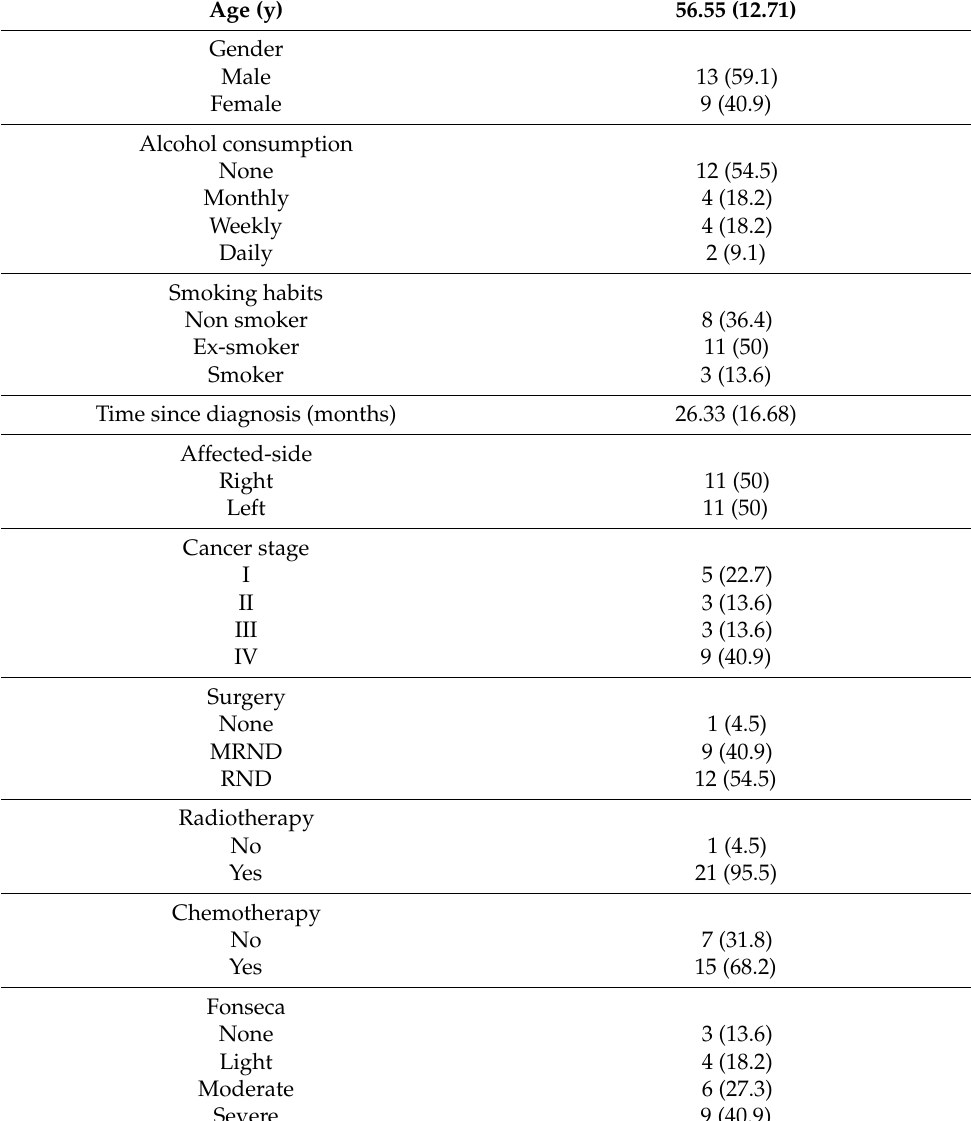
Table 1. Baseline demographic and clinical data ( n =